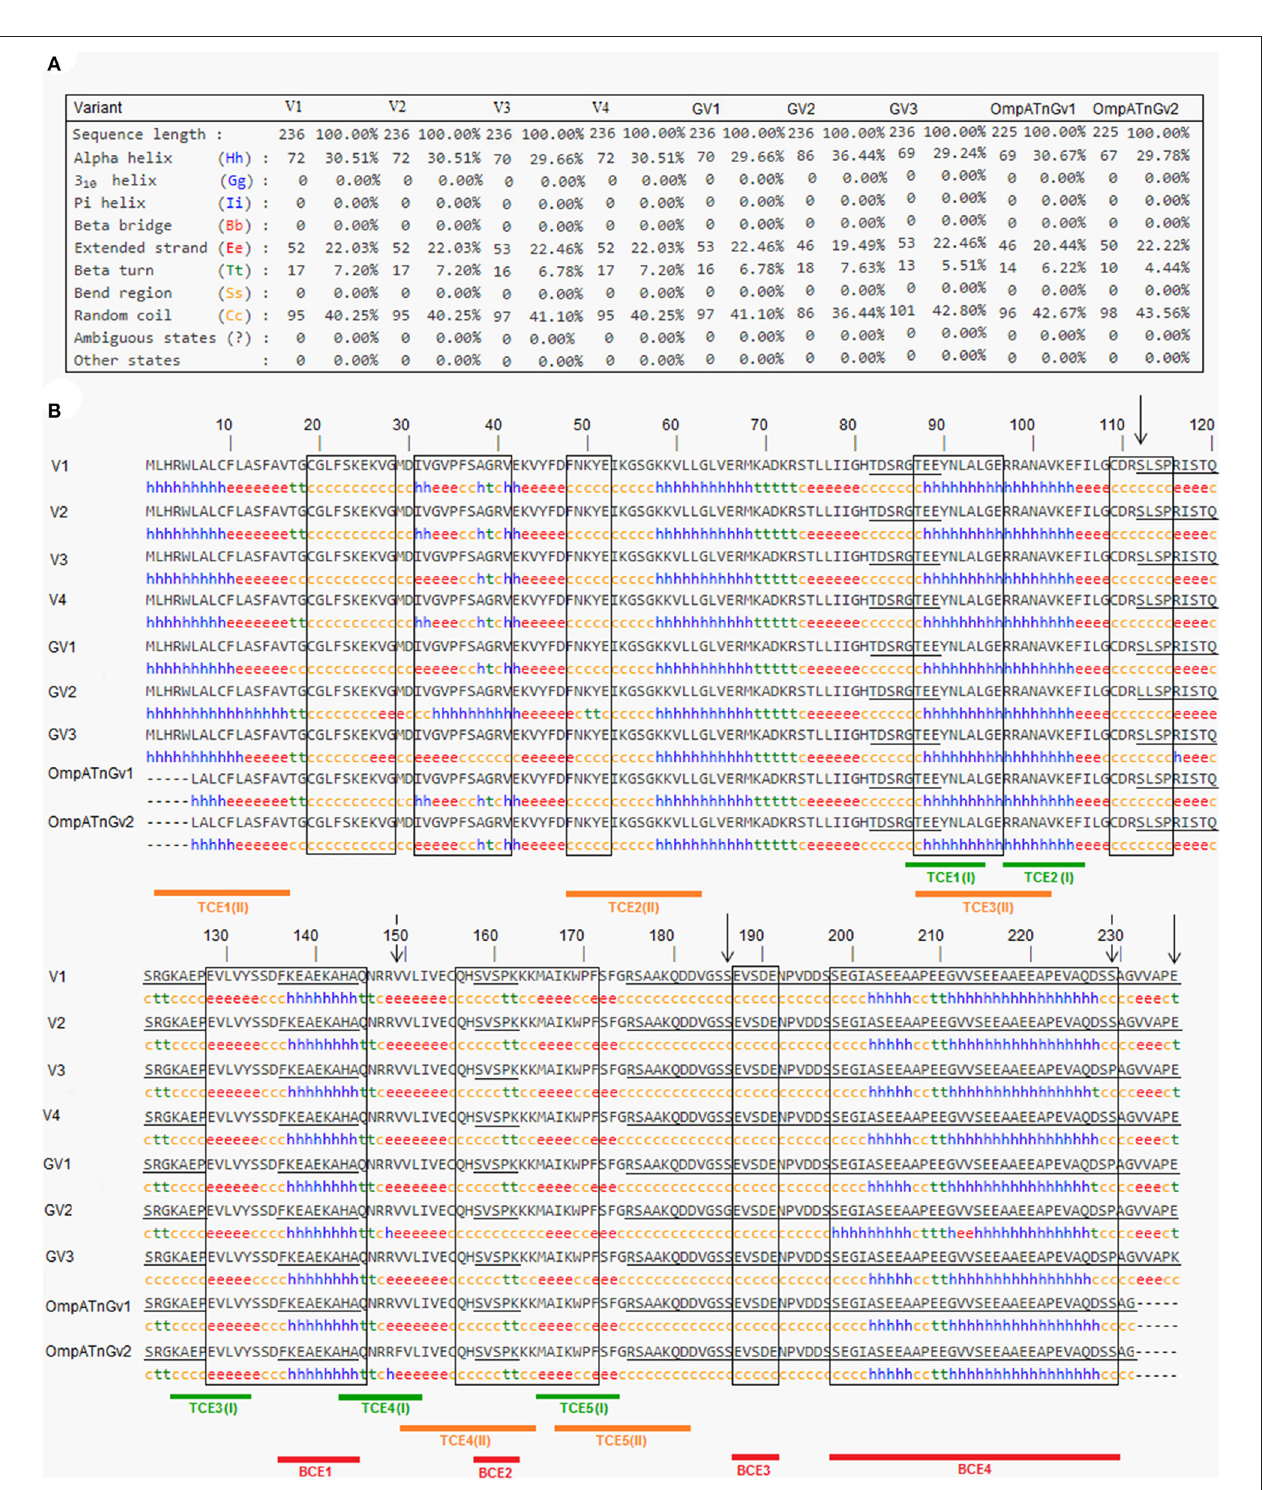
FIGURE 4 | Information on the secondary structure composition of OmpA proteins deduced from the nine genetic variants representing all Anaplasma marginale strains and isolates available in GenBank (A) and multiple alignment of predicted amino acid sequences and secondary structures of the OmpA proteins representing all A. marginale strains and isolates available in GenBank (B) . Sequential and conformational epitopes linked to B cells are, respectively, underlined and boxed. Red lines represent epitopes (BCE1–BCE4), which are in common between sequential and conformational epitopes. The green and orange lines represent the epitopes [TCE1(I)–TCE1(I)] linked to MHC class I T cells and the epitopes [TCE1(II)–TCE1(II)] binding to MHC class II T cells. The positions where there are amino acid substitutions between the analyzed protein sequences are represented by descending